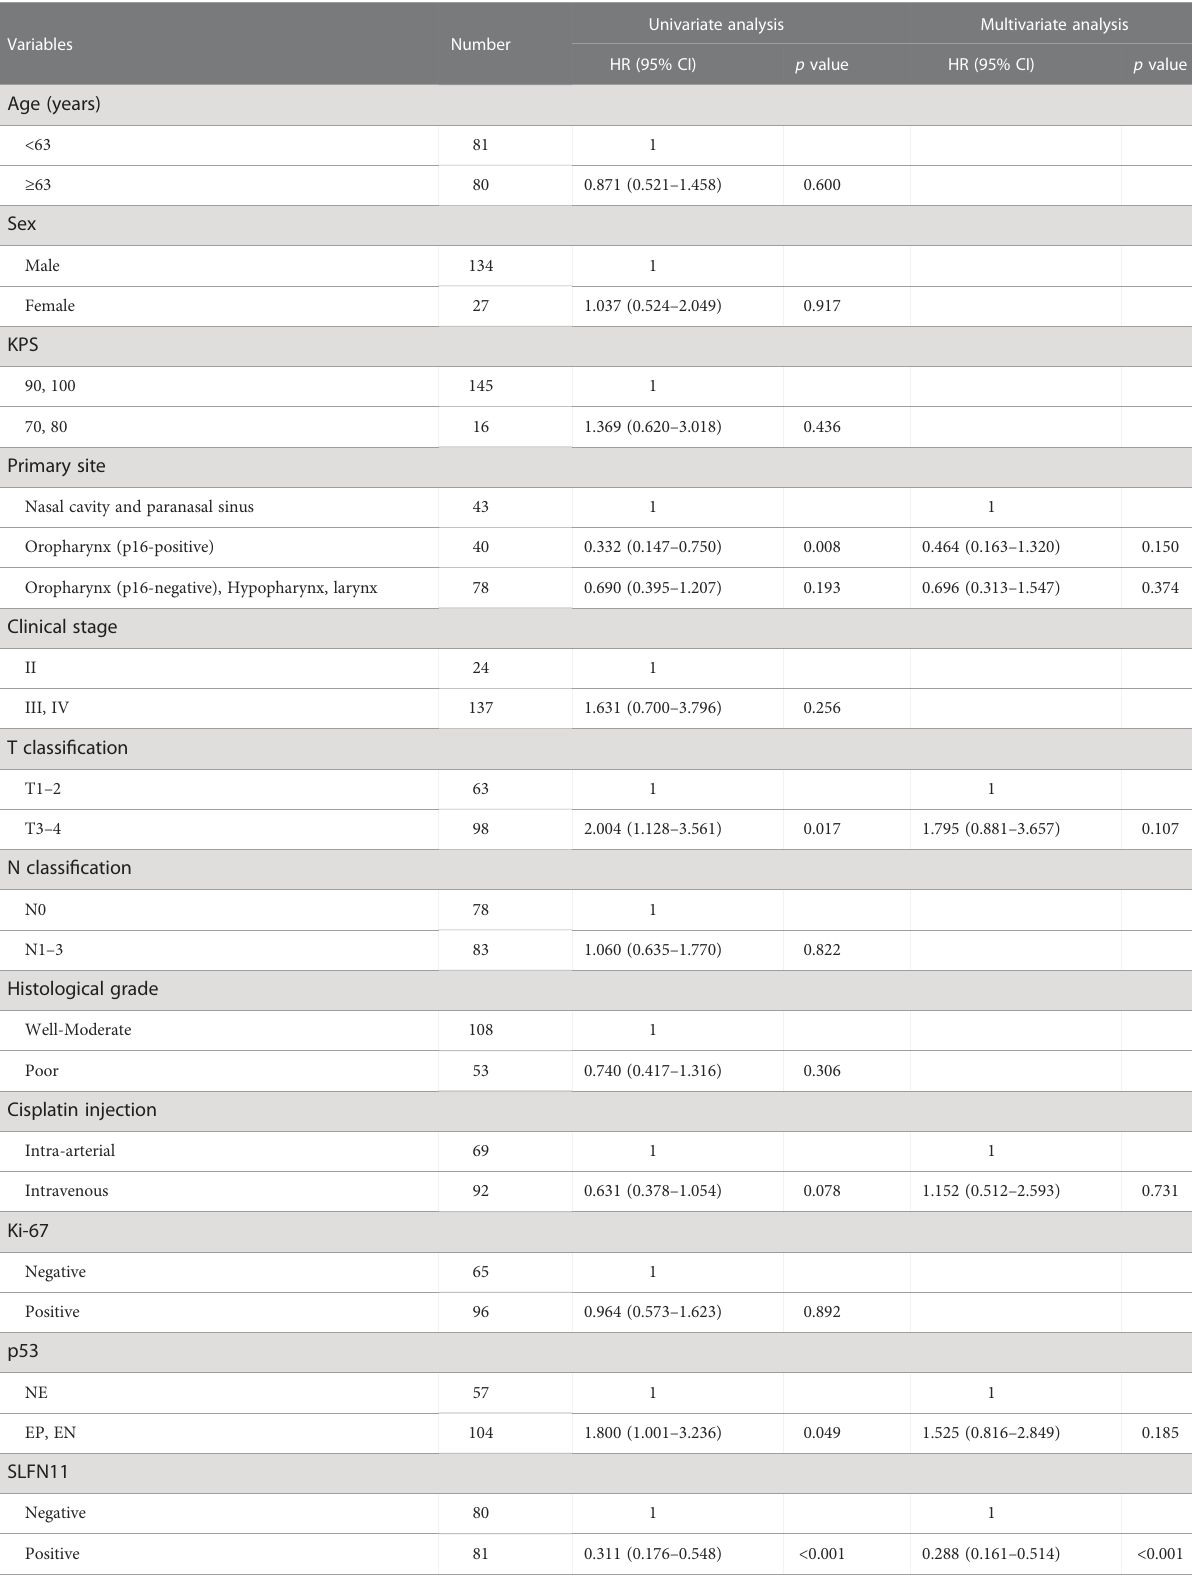
TABLE 2 Univariate and multivariate Cox proportional hazards analysis of progression-free survival in